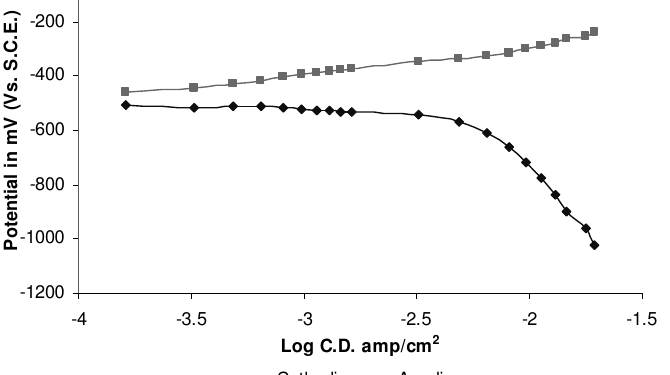
Cathodic Anodic Figure 1 . Effect of varying current density on the cathode and anode potential of tin coated steel in 0.5M monochloroacetic acid